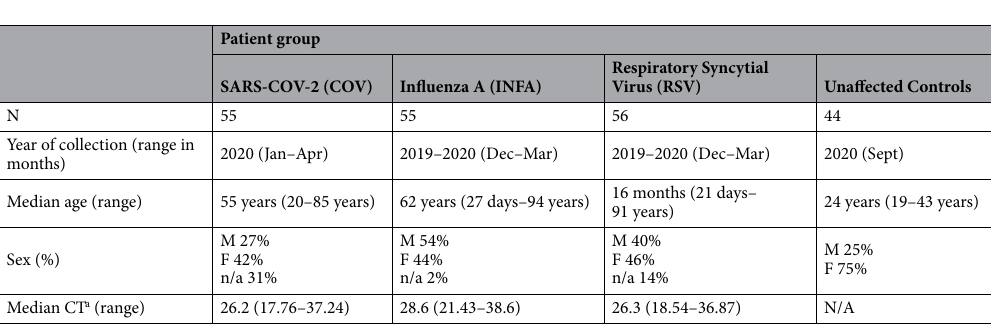
Figure 1. Experimental workflow. Viral transport medium from clinical nasopharyngeal swabs was analyzed using a TMIC Prime kit involving chemical derivatization, and liquid chromatography-tandem mass spectrometry. Multivariate and univariate statistical analyses were conducted to identify significant analytes, which we attempt to rationalize in the context of the pathogenesis of viral infection.